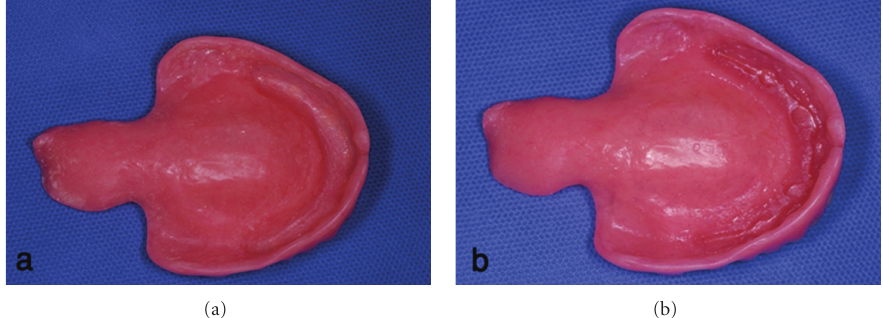
Figure 3: (a) Intaglio surface of the denture after spacer removal. (b) Intaglio surface of the denture after lining with resilient material.